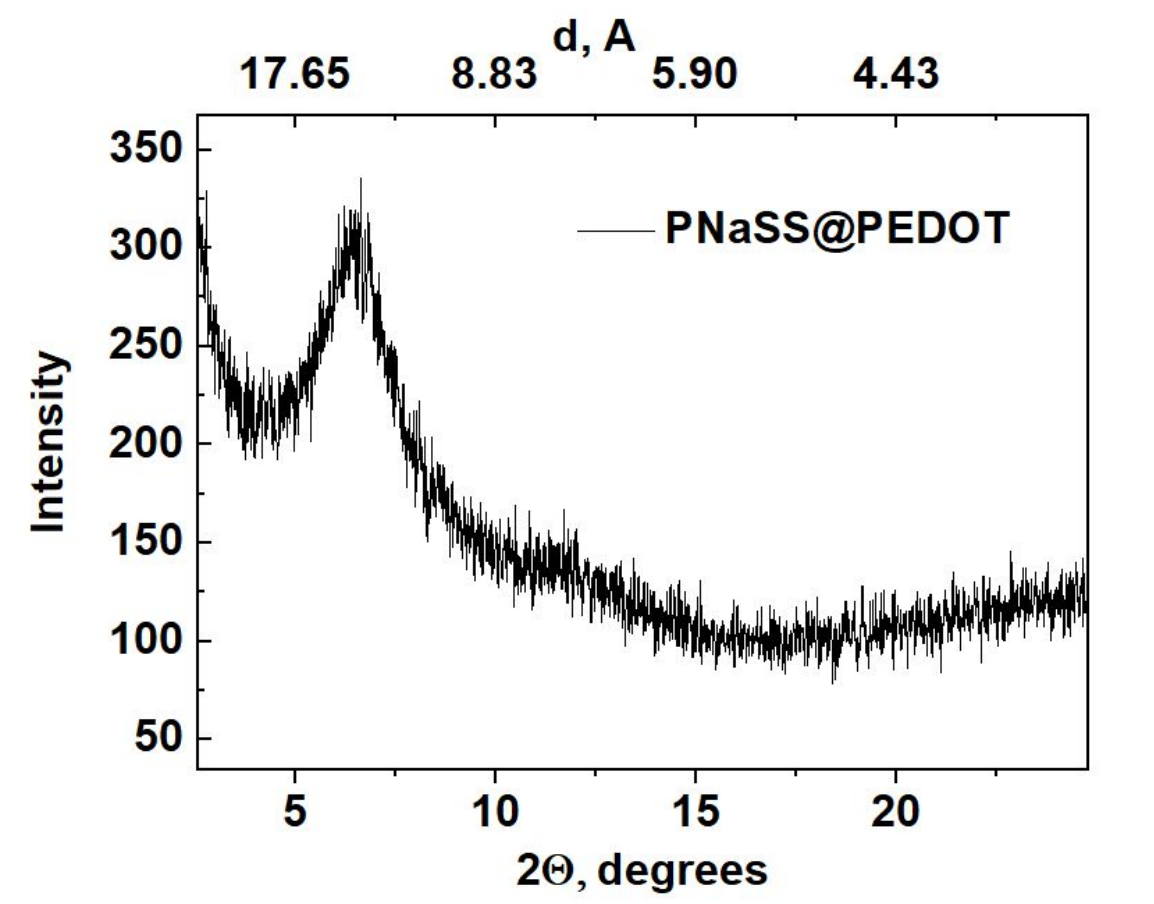
Figure 4. X-ray diffraction of PNaSS@PEDOT microsphere film deposited on FTO electrode. T he main peak (PEDOT (100)) is positioned at 2Θ = 6.55°, which corresponds to 13.48 Å ; the peak width is 1.974° [44]. Based on this value, we estimated the size of the ordered domain using the Scherrer equation. The resulting value was 40.51 Å . Another less intense, but wide peak is observed at 2Θ = 12.83° (6.89 Å). Due to the